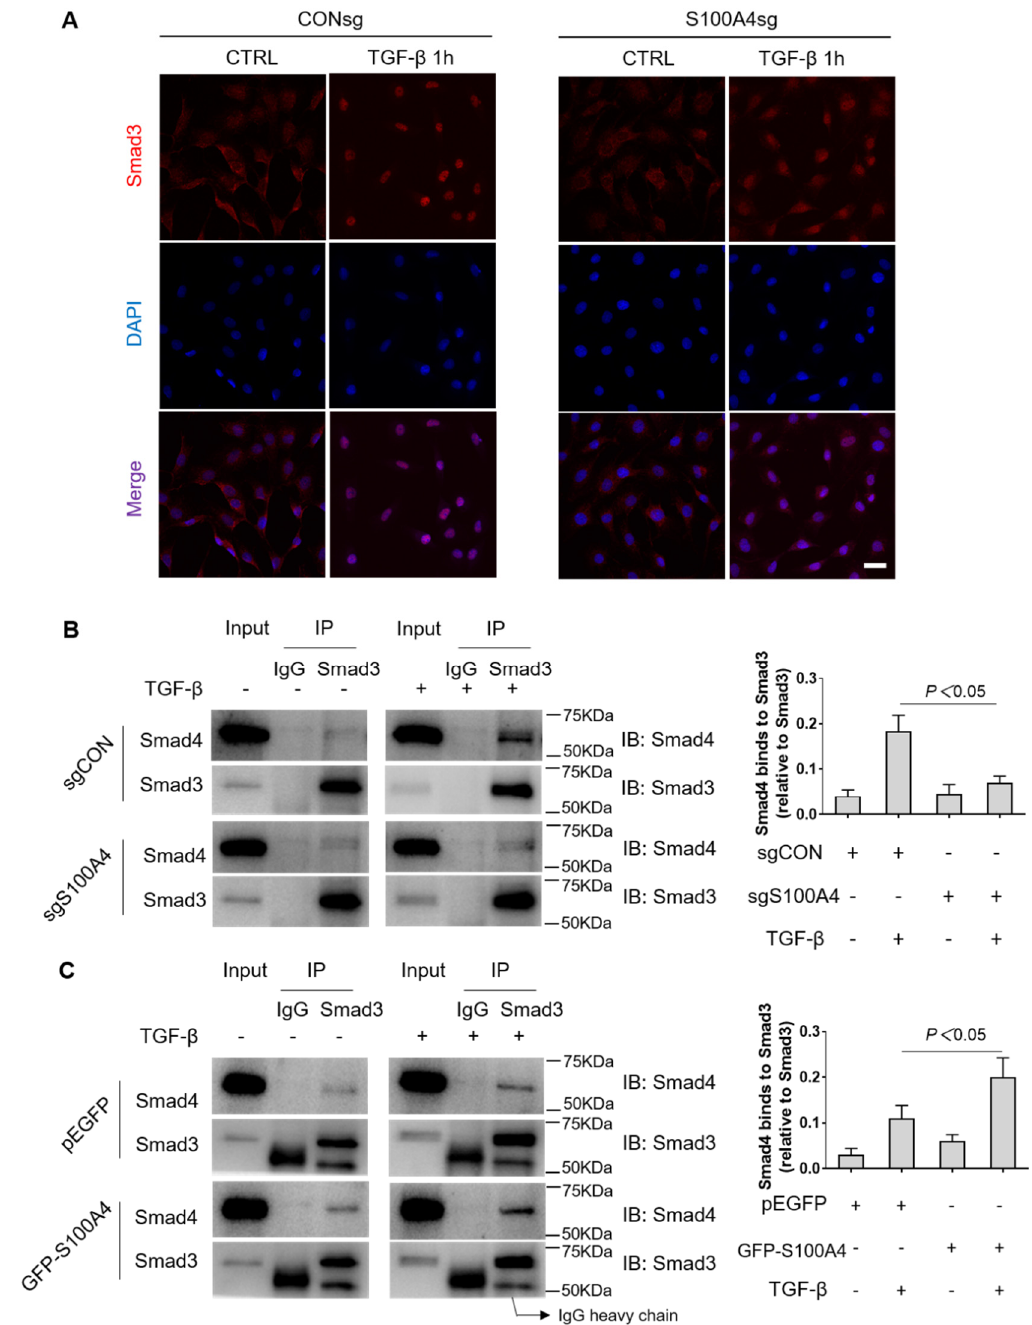
Figure 5. S100A4 promotes Smad3 nuclear translocation by stabilizing Smad3/Smad4 complex. ( A ) Representative images of immunofluorescence staining of Smad3 nuclear translocation in NRK-49F sgCON and sgS100A4 cells. Cells were treated with TGF- β 1 (2 ng/mL) for 1 h and then stained with an anti-Smad3 antibody (red), and counterstained with DAPI (blue). ( B ) NRK-49F stable cells expressing CON sgRNA or S100A4 sgRNA were treated with TGF- β 1 (2 ng/mL) for 1 h. Cell extracts were immunoprecipitated with anti-Smad3 antibody and analyzed by Western blot with an anti-Smad4 antibody. ( C ) NRK-49F cells transduced with pEGFP or GFP-S100A4 were treated with TGF- β 1 (2 ng/mL) for 1 h. Extracts were immunoprecipitated with an anti-Smad3 antibody and analyzed by Western blot with an anti-Smad4 antibody. Data are expressed as Mean ± SEM of three independent experiments. Scale bar = 50 µm.